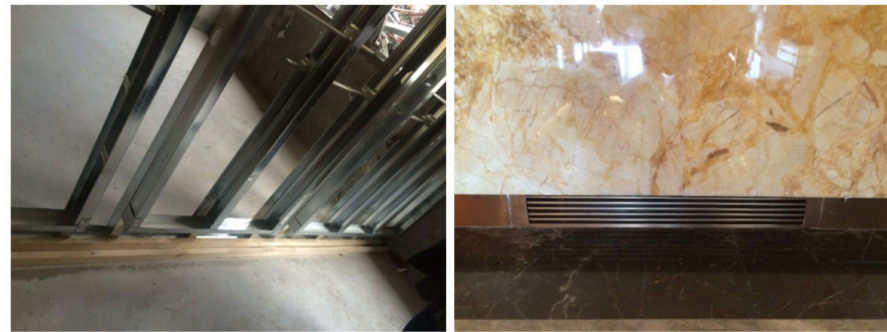
Figure 8. The construction and final result of the internal walls and the